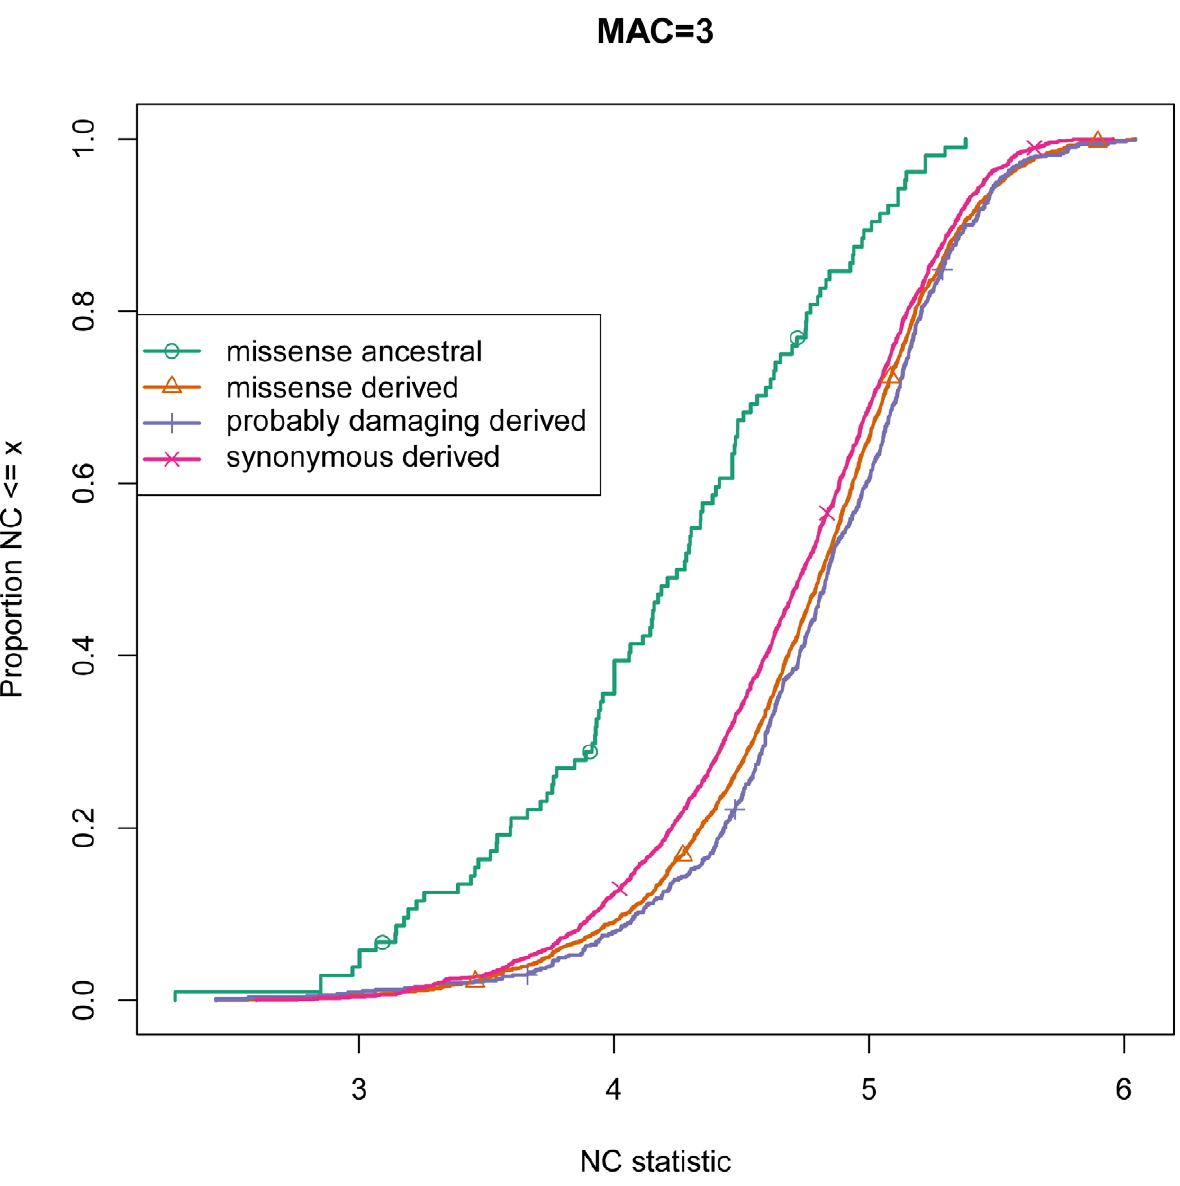
Figure 5. Empirical Cumulative Distribution Function of the NC statistic for alleles at minor allele count 3 in GoNL data. Synonymous derived variants serve as the baseline distribution. The distribution of NC for probably damaging derived missense variants is notably shifted towards higher values, consistent with their younger age. The NC-statistic distribution for ancestral alleles are at minor allele count 3 is strongly shifted towards lower values, consistent with much older age of those alleles.